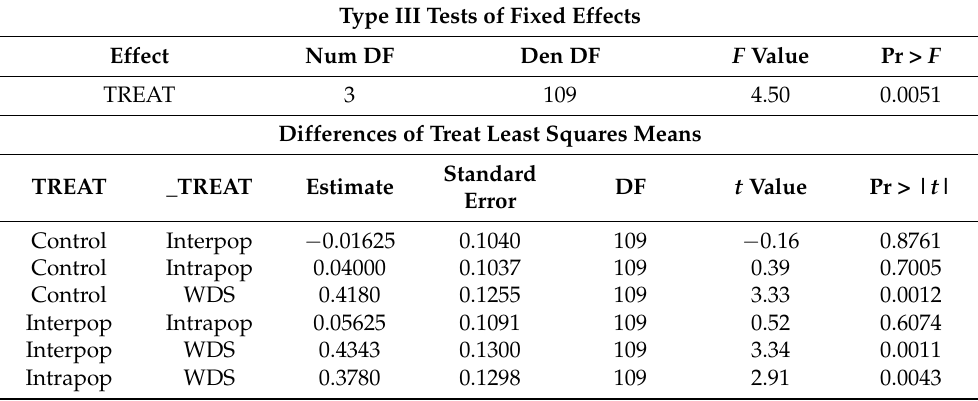
Table A6. Filled Seed Proportion (filled seeds/total ovules).